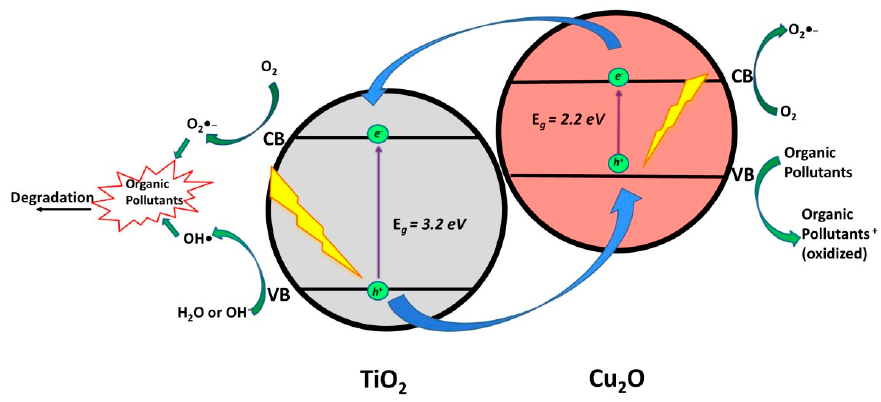
Figure 5. Photocatalytic degradation mechanism over TiO 2 / Cu 2 O composite. Table 3. Photocatalytic degradation of CEC’s over TiO 2 /MFe 2 O 4 composites.